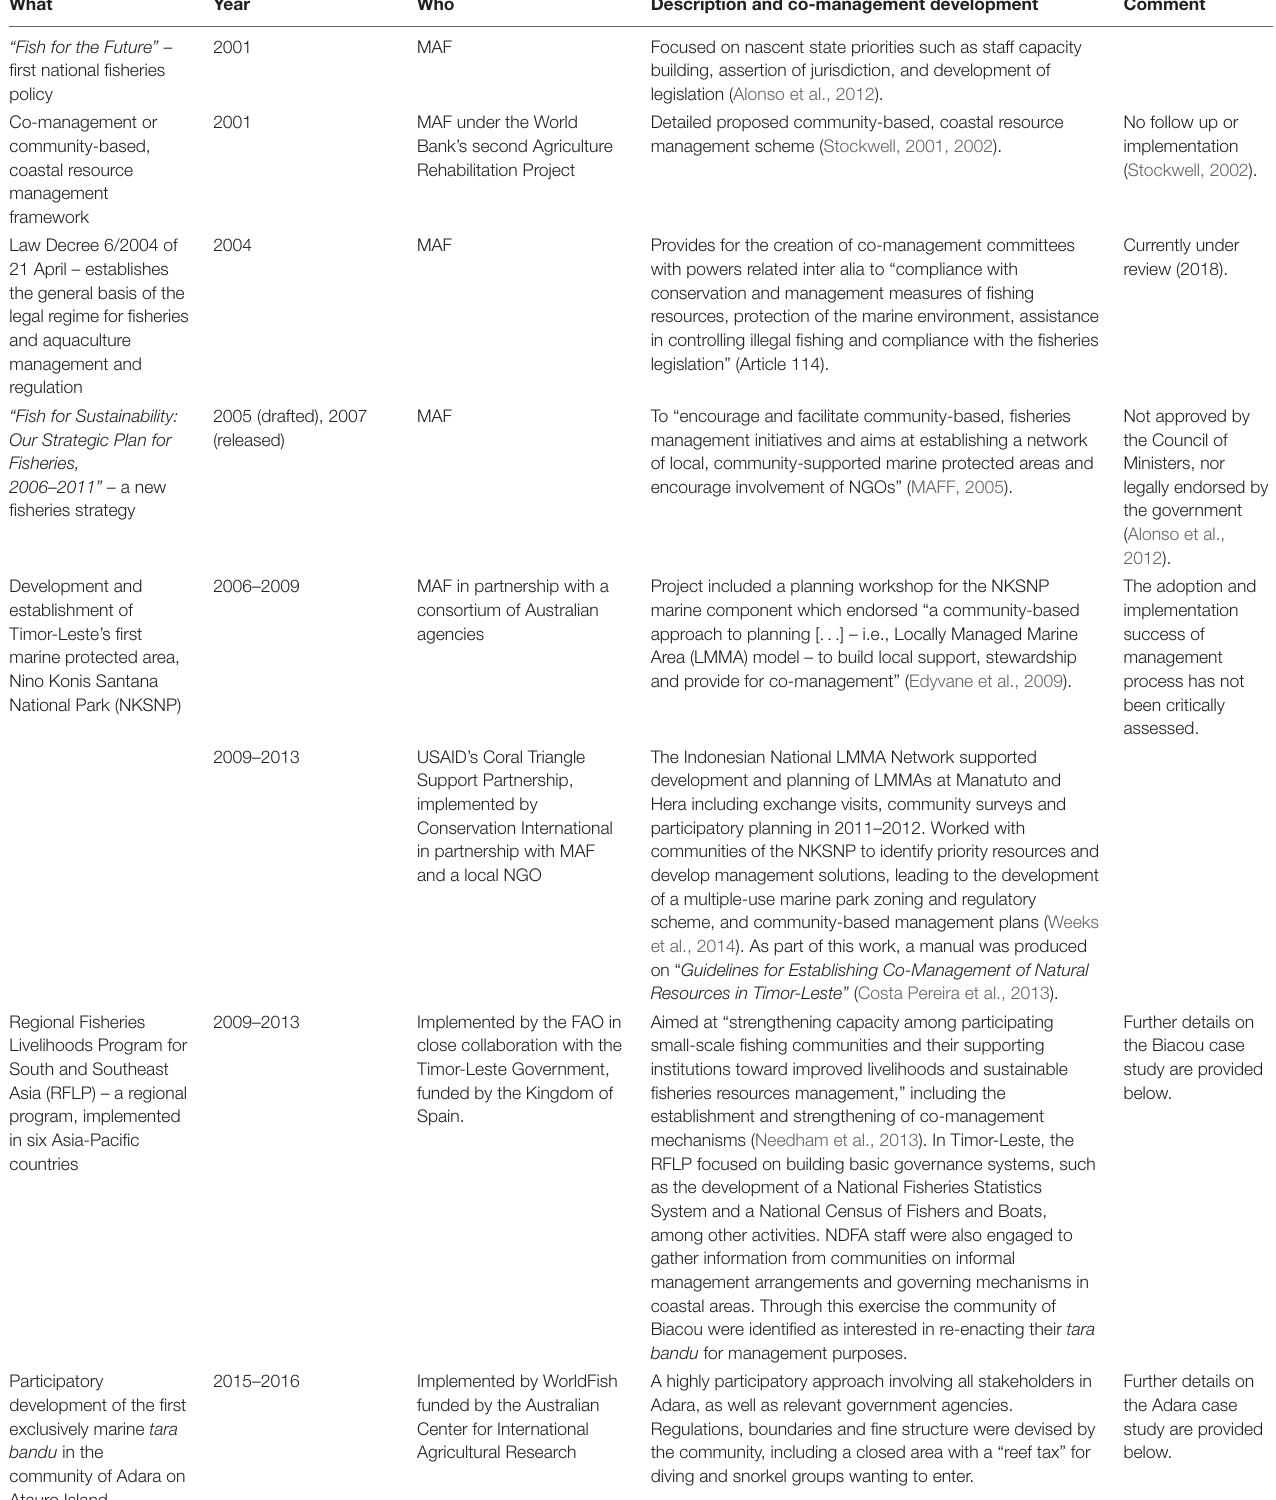
TABLE 1 | A timeline of fisheries co-management developments in Timor-Leste since